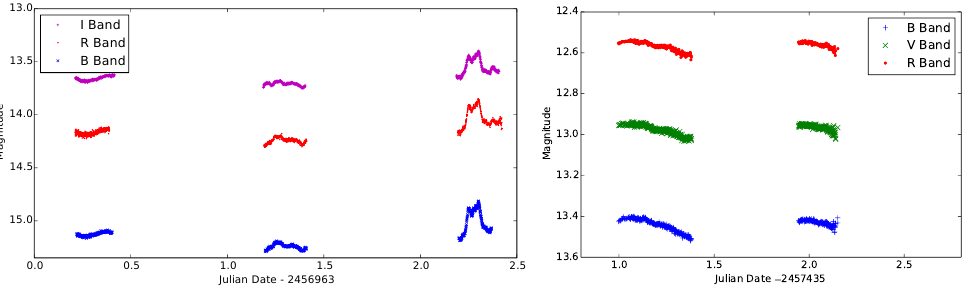
Figure 1. Overall light curves of S5 0716+714 in November 2014 (left panel) and February 2016 (right